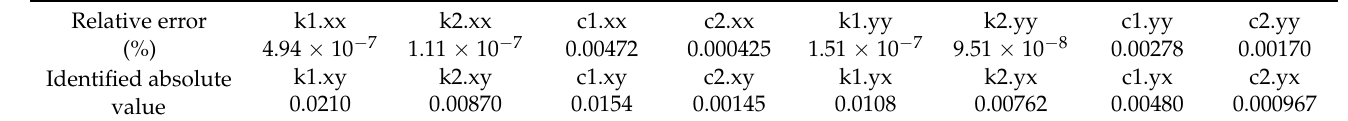
Table 15. The biggest identification error using the computational example g1.4.